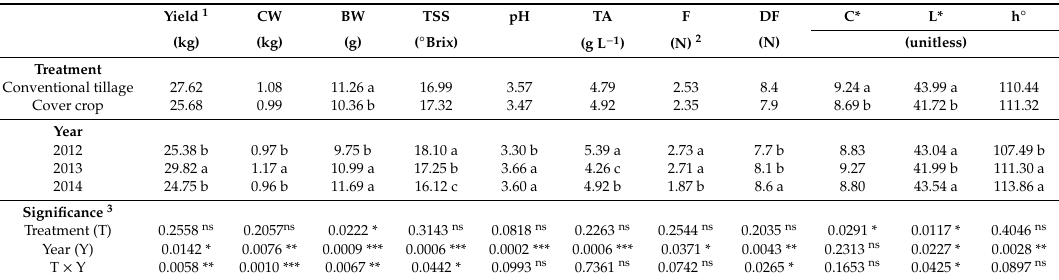
Table 4. E ff ect of the soil management system (treatment), growing season (year) and their interaction (treatment × year) on the quantitative and qualitative grape